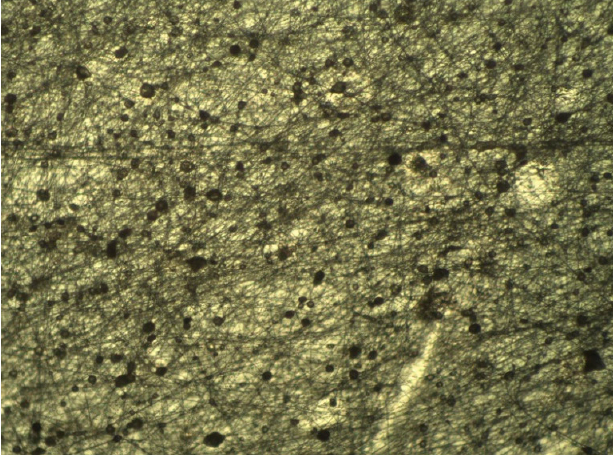
Figure 6. Optical microscope image of the electrospun 50% ethanol extracts. 100 ×